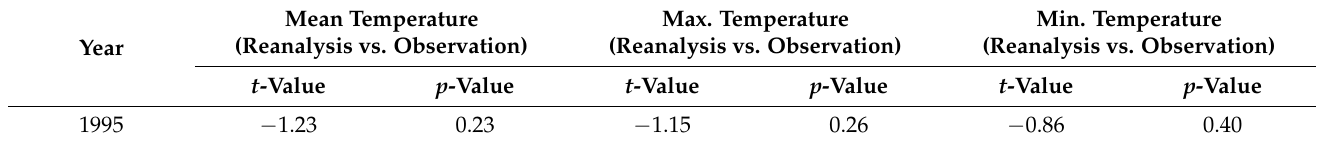
Table 4. Summary of the independent t-test results of reanalysis versus observation annual temperature data.